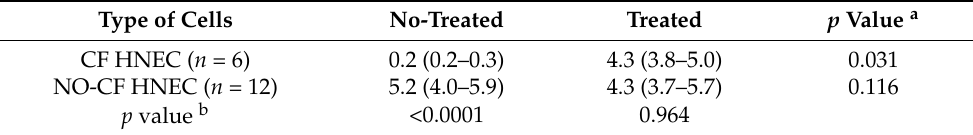
Table 2. Kaftrio TM effect on CFTR-dependent Cl-secretion in CF and NO-CF nasal epithelial cells. Type of